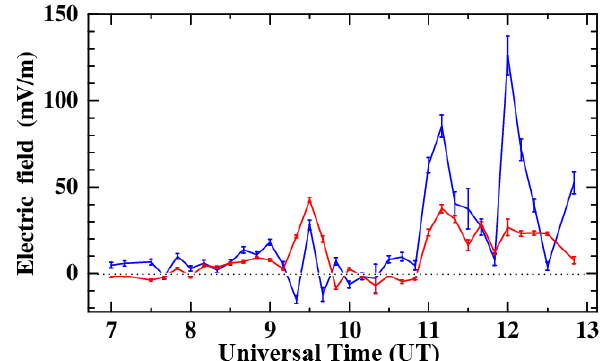
Figure 7. Ion temperature variations at about 300km altitude on 12 March. The black line indicates the ion temperature observed with ESR 42m at Longyearbyen. The red, blue, and green lines show the ion temperatures derived from the EISCAT UHF radar observations at Tromsø with beam 2, beam 3, and beam 4, respec- tively. The red dotted line shows the ion temperature derived from the EISCAT UHF observations at Tromsø with beam 1.